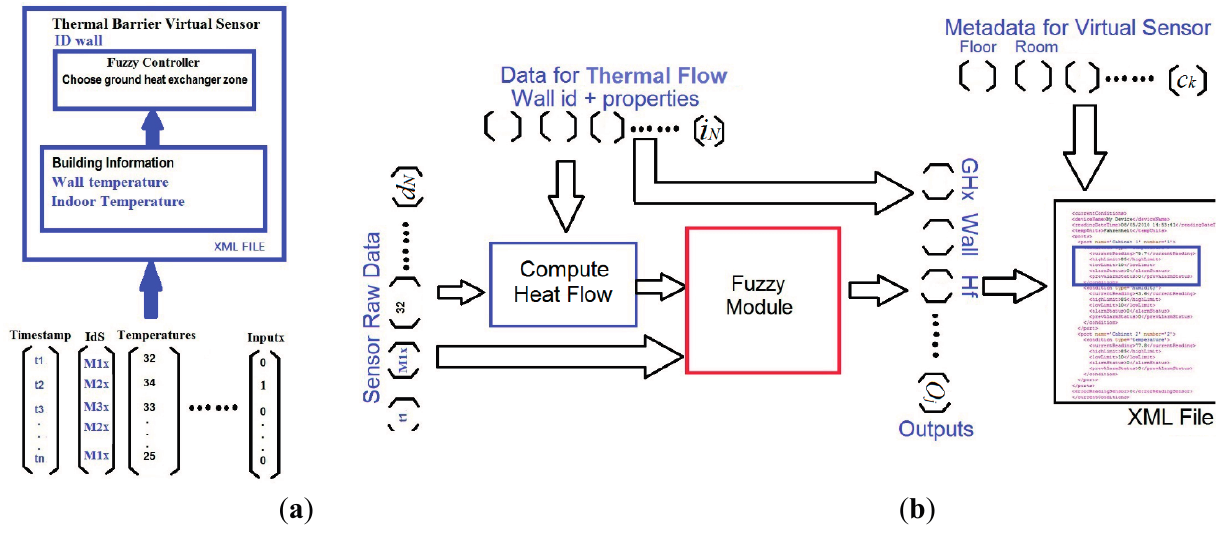
Figure 16. Thermal Barrier Virtual Sensor. ( a ) Inputs; ( b ) Components and data